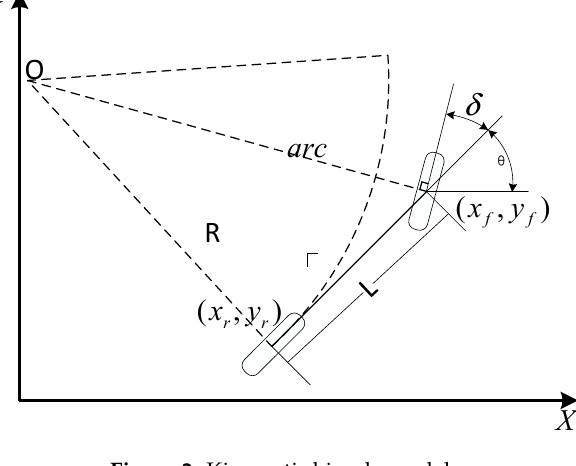
Figure 2. Kinematic bicycle model.